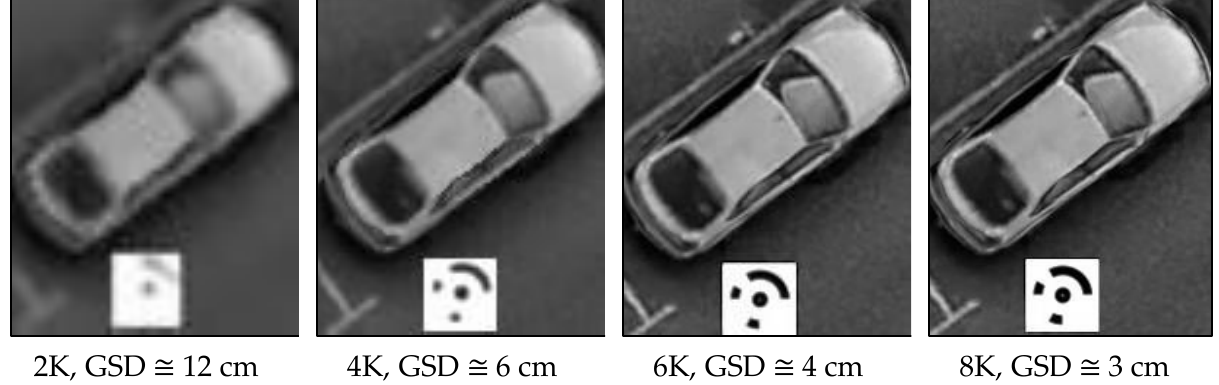
Figure 2. Illustration of the relation between the increasing drone video resolution and the GSD at the same flying height of 85 m.